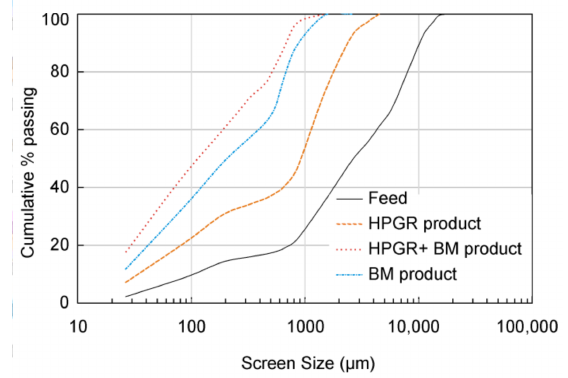
Figure 5. Particle size distribution curves for the feed and ground products.